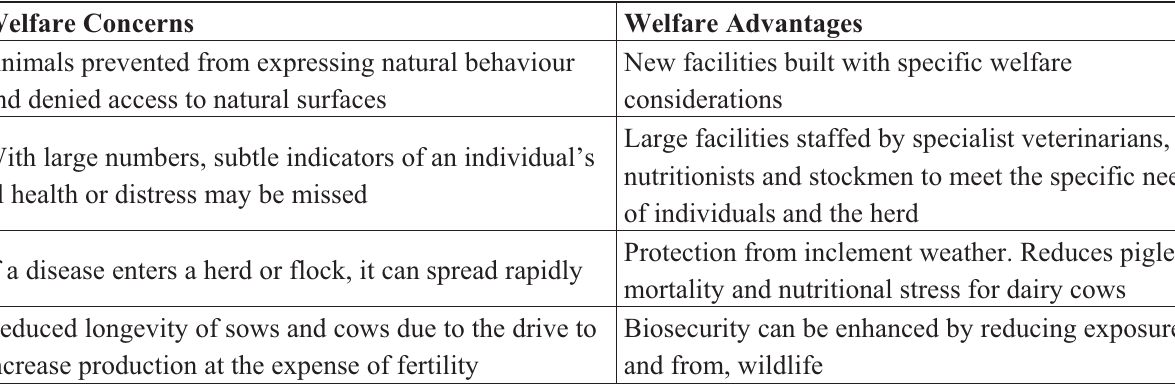
Table 2. Welfare issues of farm animals associated with intensive indoor housing systems (adapted from